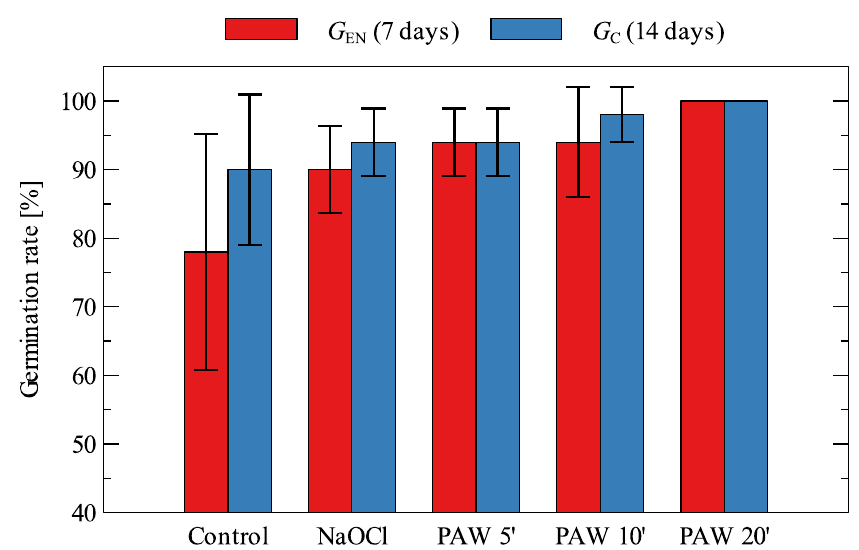
Figure 2. Germination of Beta vulgaris (mean values and standard deviation). The germination results obtained for Daucus carota are shown in Figure 3.